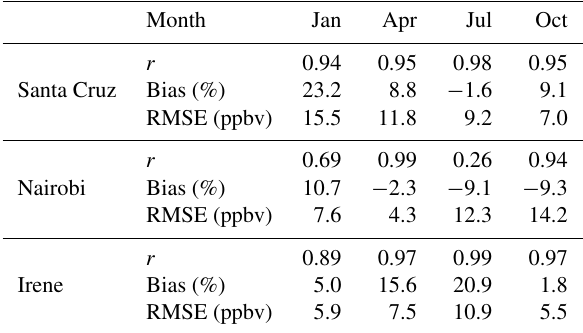
Table 1. The ozone vertical profiles (see Fig. 2) simulated with GEOS-Chem in comparison with the ozonesonde measurements at Santa Cruz, Nairobi, and Irene in Africa in terms of bias (in %), root-mean-square error (RMSE, in ppbv), and correlation coeffi- cient ( r ) in the four seasons. Month Jan Apr Jul Oct Santa Cruz